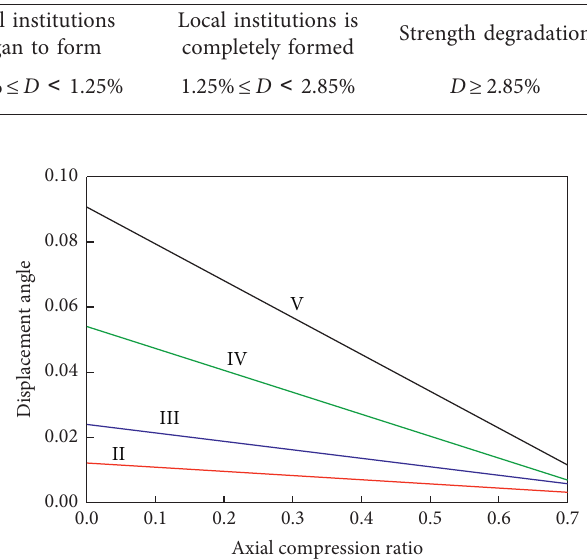
Figure 1: Influence of the axial compression ratio on the allowable displacement angle of the pier